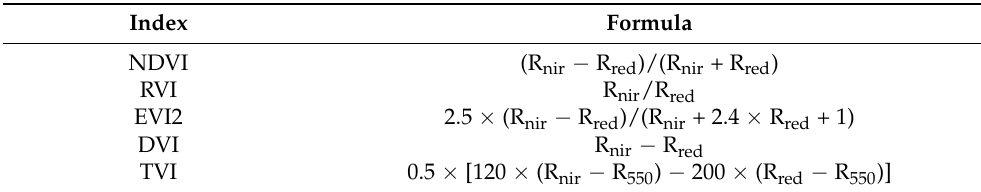
Table 1. The formulae of the five spectral indices that were used to construct the models to estimate the cotton leaf area